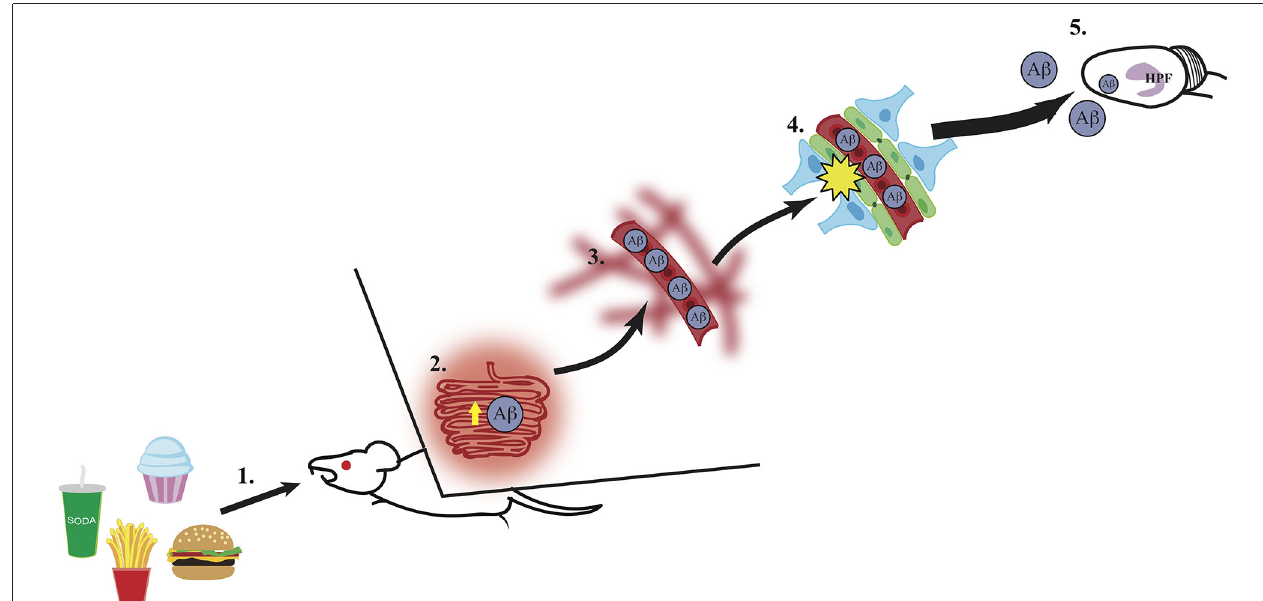
barrier damage via reduction of gene expression of tight junction proteins (e.g., occludin, claudin 5; illustrated in green), (5) which leaves the hippocampal formation (HPF) vulnerable to damage by excessive A β accumulation and other circulating toxins (e.g., heavy metals, inflammatory